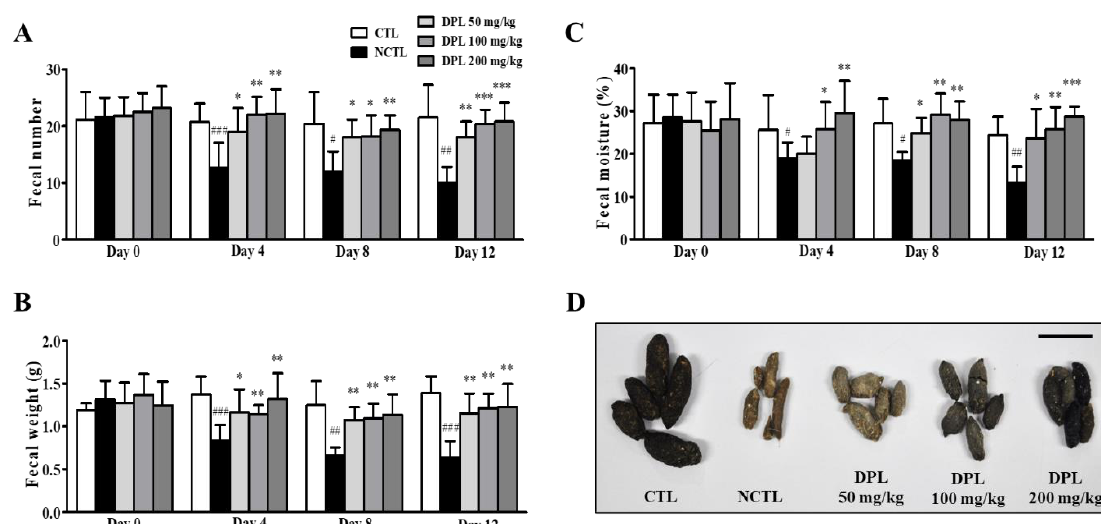
Figure 3. The preventive effects of D. morbiferus H. Lév. leaf extract (DPL) on low-fiber diet-induced constipation. At 0, 4, 8, and 12 days, the total number ( A ), weight ( B ), and water content ( C ) of stools were measured. The fecal water content was calculated using the fresh and dry weights of stools. ( D ) Stool morphological characteristics. At 12 days, digital camera images of the stools were taken after collection. Scale bar represents 1 cm. Stools were collected from seven rats per group, and each parameter was assayed in triplicate. Each bar represents the mean ± SD for seven rats. # Significant difference at p < 0.05, ## at p < 0.01, and ### at p < 0.001 compared with the control group (CTL). * Significant difference at p < 0.05, ** at p < 0.01 and *** at p < 0.001 compared with the low-fiber diet-induced constipation group (negative control group; NCTL).